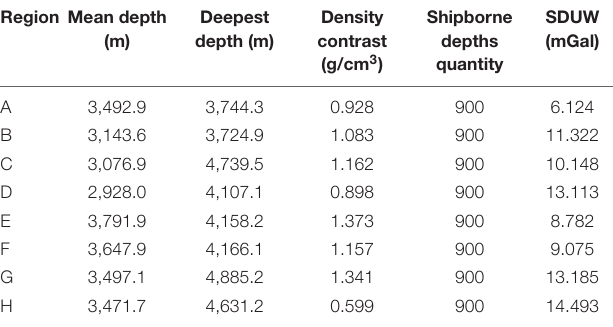
TABLE 2 | Density results derived from TLS.